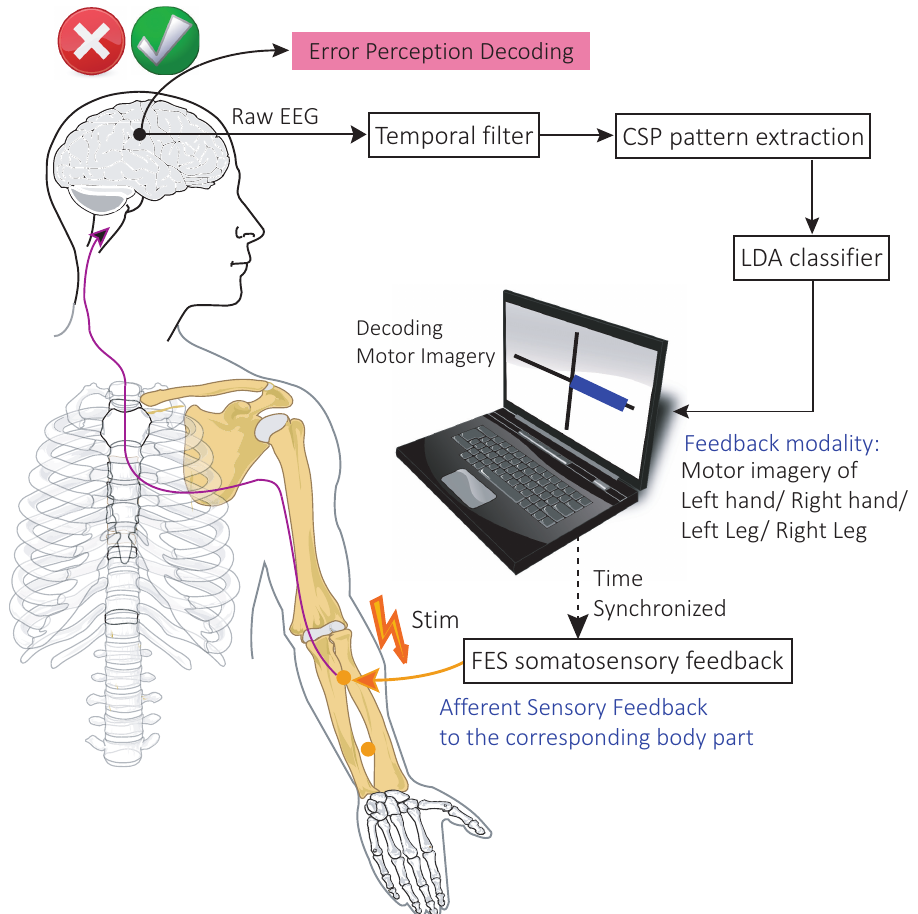
Figure 1. Representation of the online BCI system for the VIS and FES groups, as described in Section 2. Based on the LDA classifier output, the occurrence of ErrP signals is expected to be detected from incorrectly classified trials (as mentioned